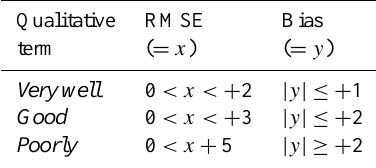
Table 4. Definition of qualitative terms used to describe JULES’ ability to simulate GPP when compared to observed FLUXNET GPP. Both RMSE and Bias have units of gCm − 2 day − 1 . Starting at “ Very well ”, the term associated with the first condition satisfied is used to describe model